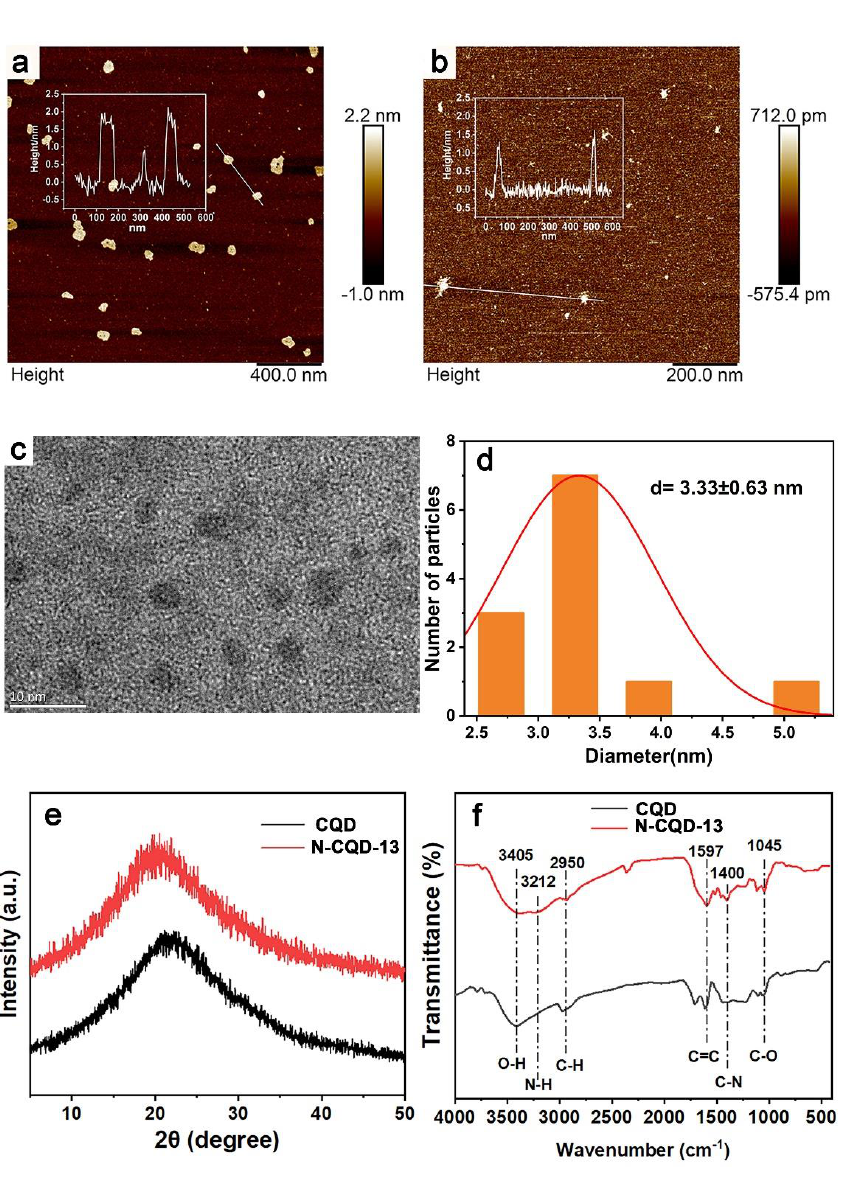
Figure 3. AFM image of CQD ( a ) and N-CQD-13 ( b ). (Inserted with height statistics). TEM image ( c ) and size distribution ( d ) of N-CQDs-13 . XRD patterns ( e ) and FT-IR spectra ( f ) of CQD and N-CQD-13 .